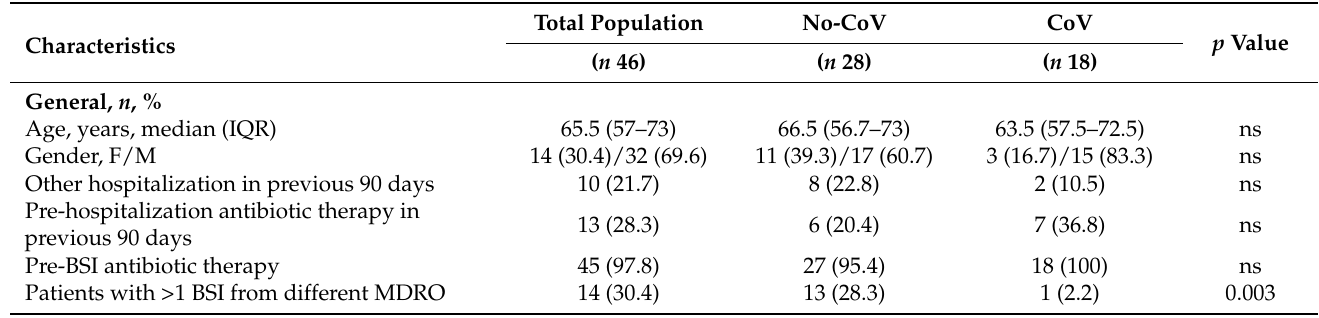
Table 1. Characteristics of the study population. Demographic, clinical characteristics, outcomes of the study population and microbiological data, and clinical and treatment characteristics of the BSI